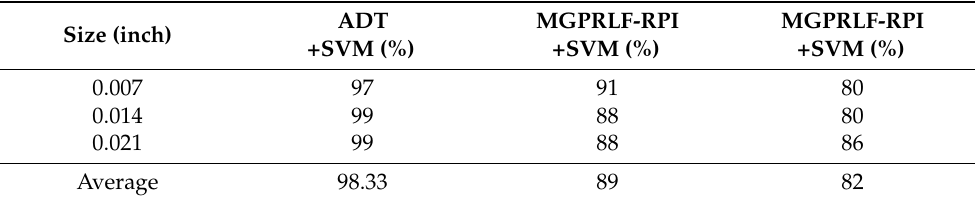
Table 8. The average accuracies of outer crack size identification using the ADT+SVM, MGPRLF- RPI+SVM, and MGPRLF-PI+SVM